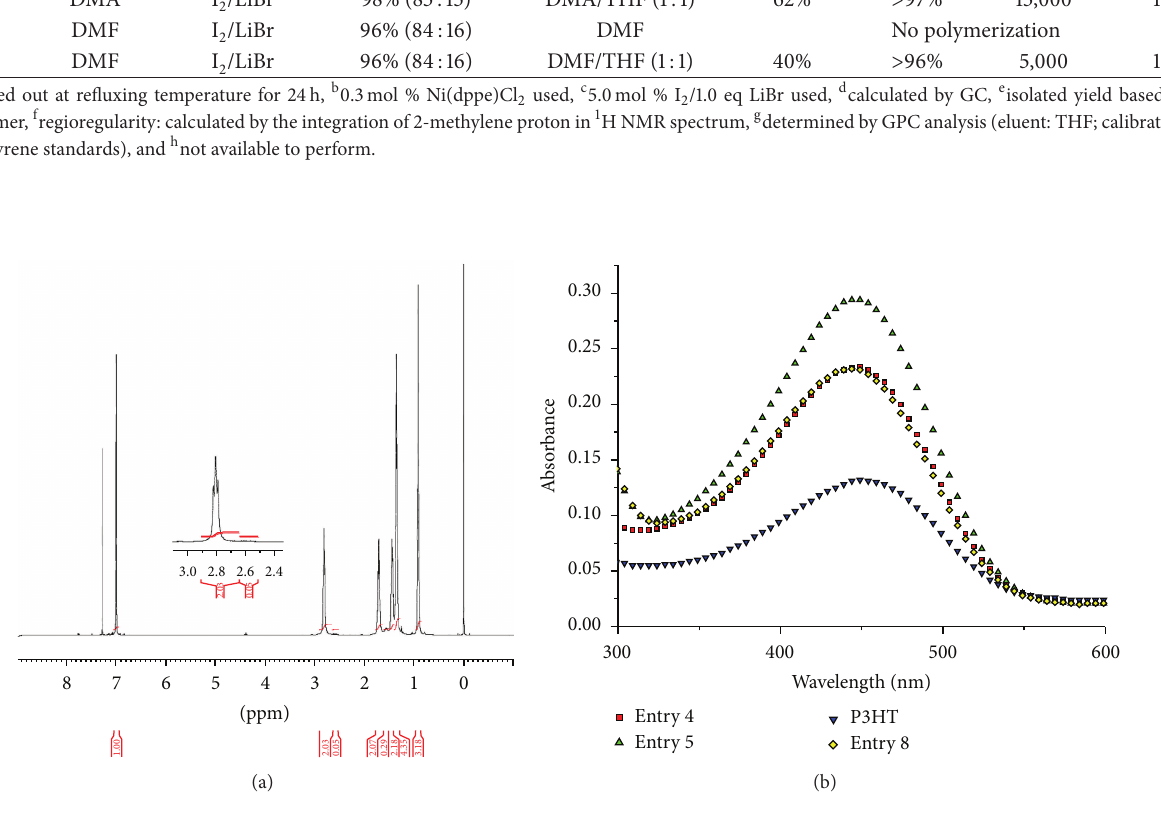
Figure 1: 1 H NMR ((a), in CDCl 3 ) and UV spectra ((b), in CHCl 3